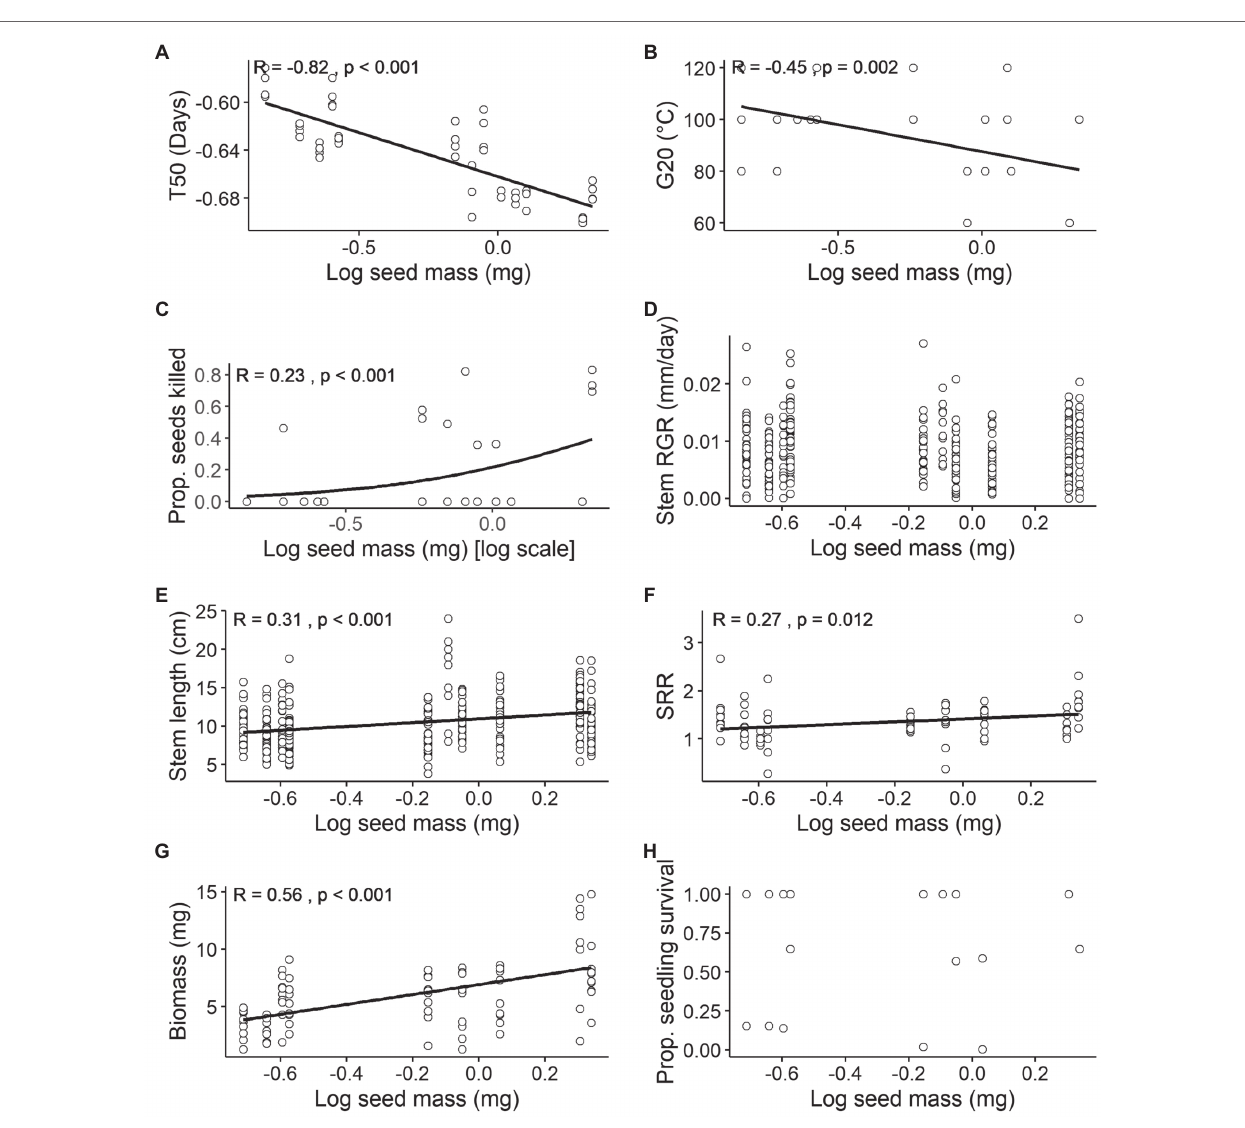
FIGURE 3 | Relationships between mean seed mass (mg) [log scale] and seed and seedling traits. Sample size ( n ) varies within each trait. (A) Germination speed T 50 (days; n = 4 per species), Tukey’s ladder transformation, (B) minimum dormancy-breaking temperature thresholds G 20 ( ° C; n = 4 per species), (C) seed mortality (proportion of seeds killed) at 120 ° C treatment ( n = 4 per species), (D) Relative growth rate (RGR) of stem length (mm/day; n = 25 per species for each treatment), (E) stem length (mm; n = 25 per species for each treatment), (F) shoot to root ratio (SRR; n = 5 per species for each treatment), (G) biomass (mg; n = 5 per species for each treatment) and (H) seedling survival (proportion of survived seedlings calculated based on ( n = 25) sample size per species per treatment) on combined watered and drought treatment. All continuous variables were tested using Pearson’s correlation and binomial responses using Generalised Linear Models (GLMs). For significant relationships, the line of best fit has been plotted. No line denotes non-significant associations among